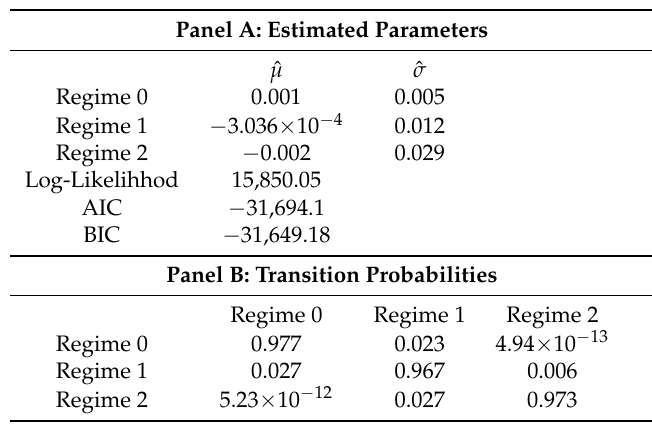
Table 1. 3-Regime Markov-switching models: estimated parameters for the S&P 500 index returns (years 2001–2020). AIC and BIC are the Akaike and Bayesian Information Criterion, respectively.